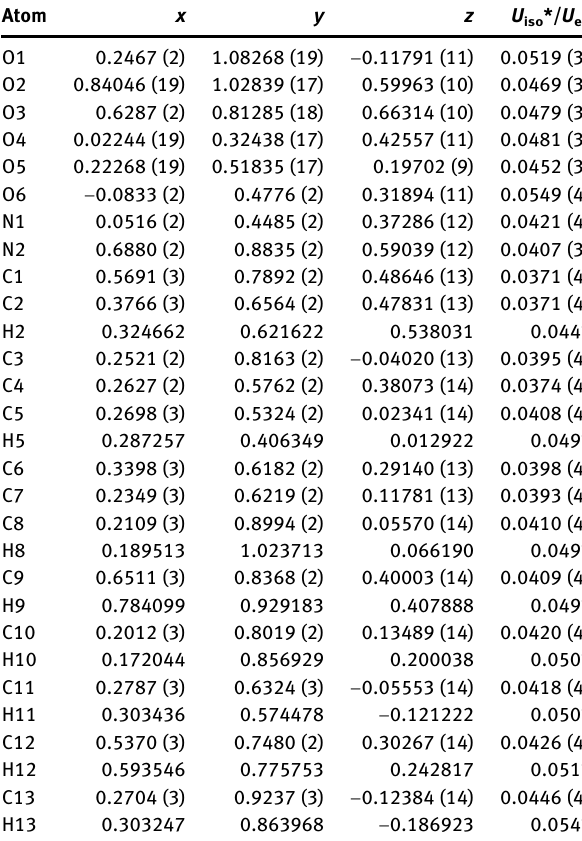
Table  : Fractional atomic coordinates and isotropic or equivalent isotropic displacement parameters (Å 